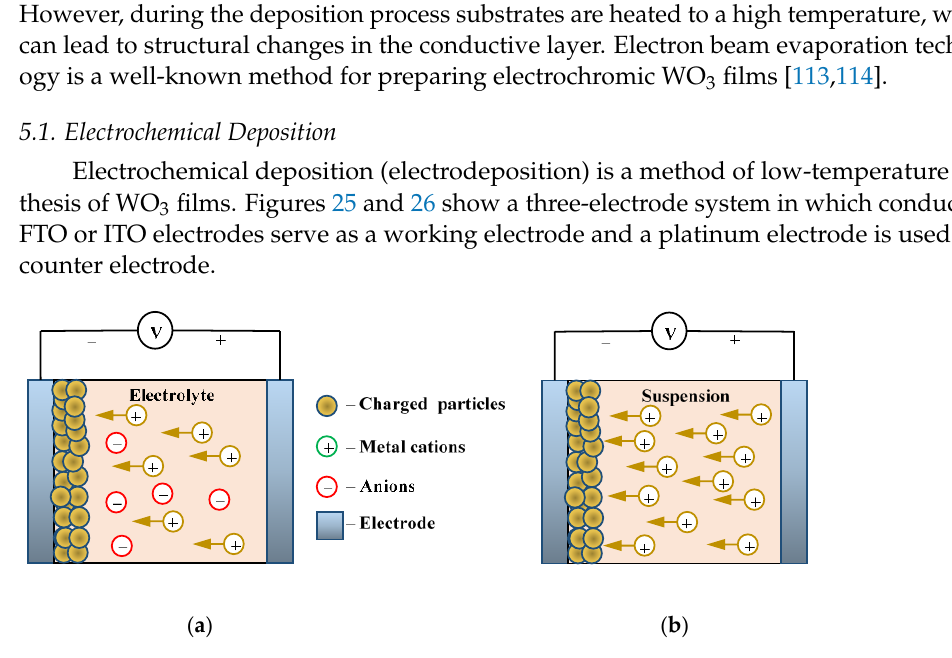
( b ) Figure 25. Two types of electrodeposition processes: ( а ) electroplating; ( b ) electrophoretic deposi- tion.